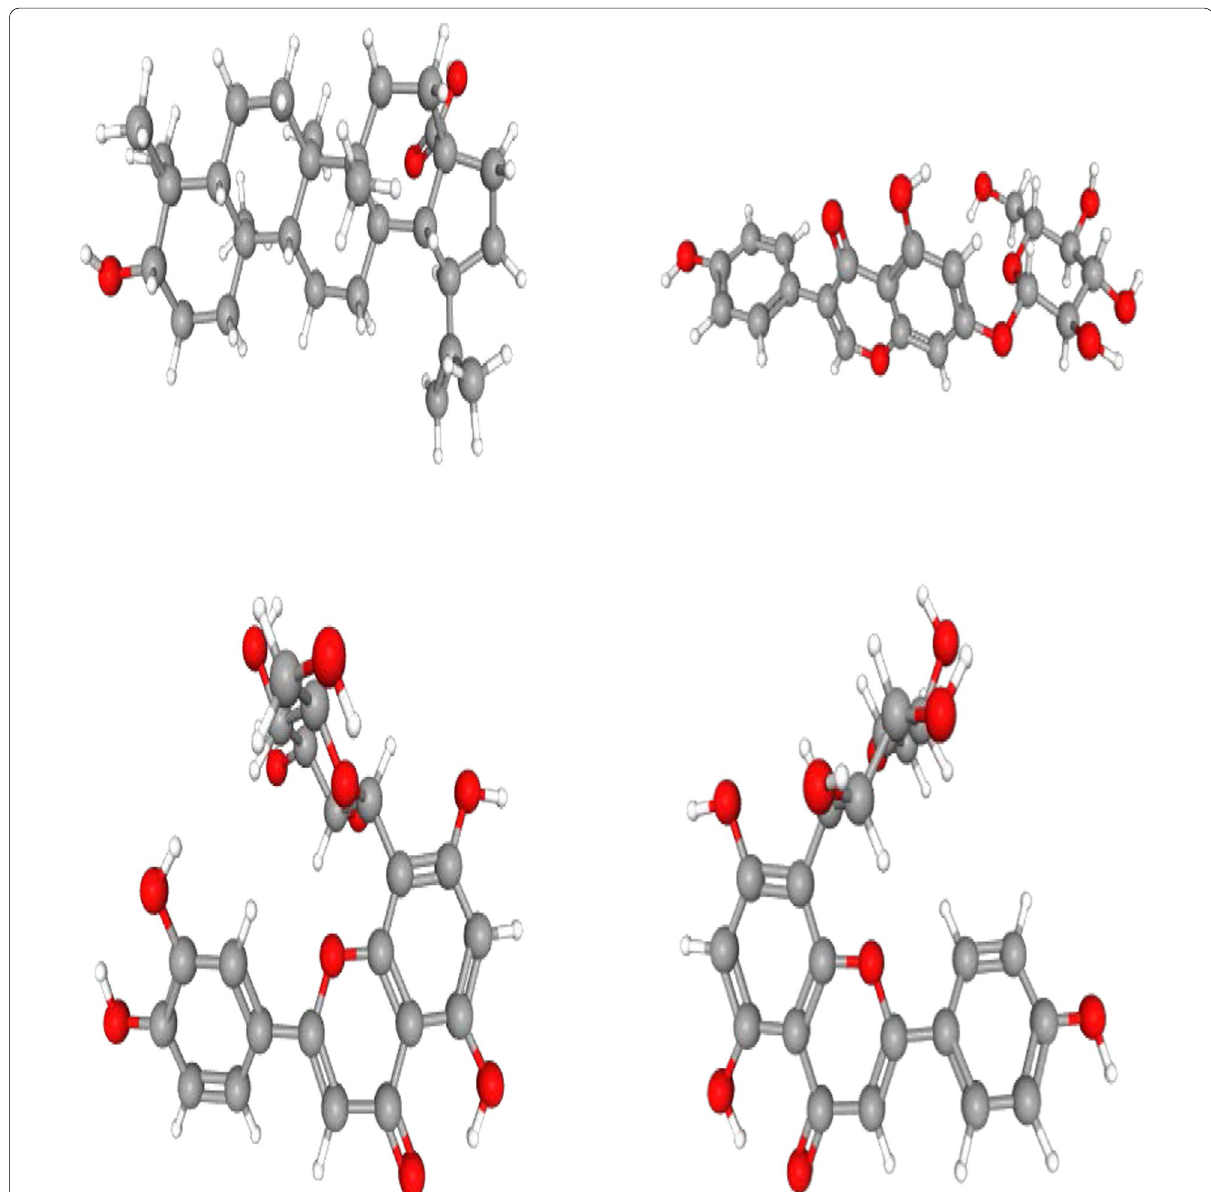
Fig. 14 Structure of five potential HDAC inhibitor from Cajanus cajan a betulinic acid b genistin c orientin d vitexin